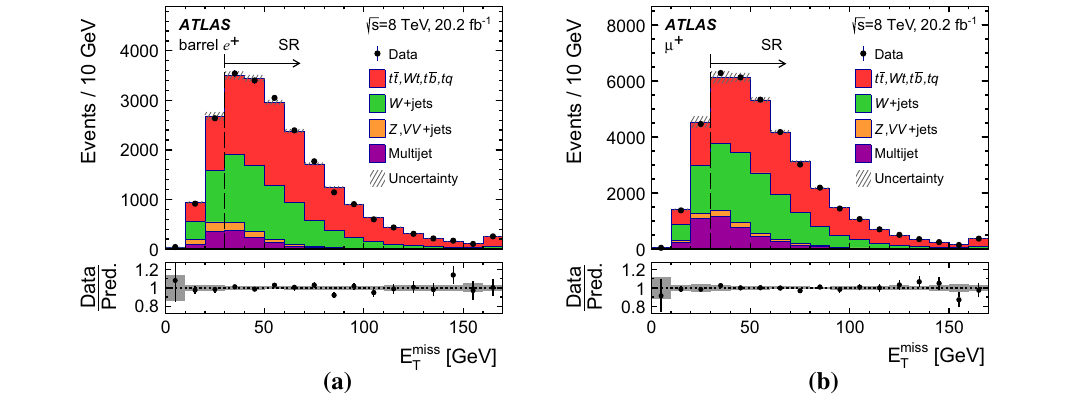
Fig. 2 Observed distributions of the missing transverse momentum, SR. The hatched uncertainty band represents the MC statistical uncer- < 30GeV, E miss tainty and the normalisation of the multijet background. The ratio of , in the signal region (SR), including events with E miss T T observed (Data) to predicted (Pred.) number of events in each bin is for a events in the e + channel with an electron in the barrel region shown in the lower panel . Events beyond the x -axis range are included and for b events in the μ + channel, compared to the model obtained in the last from simulated events. The normalisation is obtained from the binned maximum-likelihoodfittothefull E miss distributions,andappliedtothe T